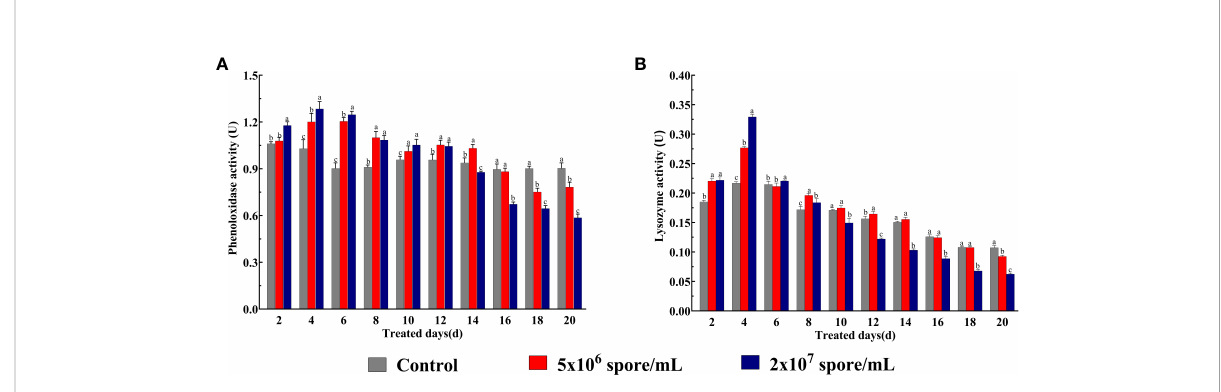
FIGURE 2 Phenol oxidase (PO) and lysozyme activities in L . migratoria manilensis infected with P. locustae. (A) PO activity of adult females were infected by P. locustae on days 2 – 20. (B) Lysozyme activity of adult females infected by P. locustae on days 2 – 20. Each value is presented as mean ± SD, and different letters indicate signi fi cant differences among different treatments at the same time point (two-way ANOVA followed by Tukey ’ s multiple comparisons test, P < 0.05).